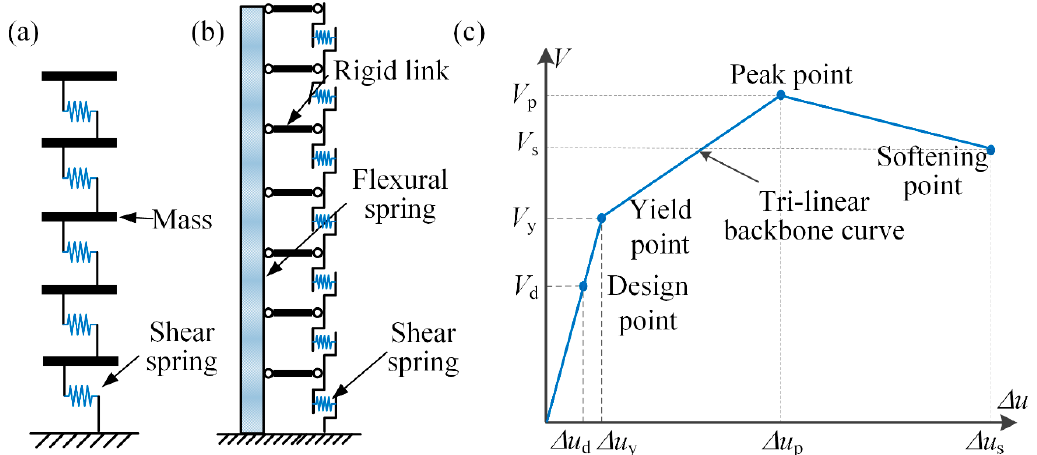
Figure 2. ( a ) Multiple-degree-of-freedom (MDOF) shear model; ( b ) MDOF flexural-shear model; and ( c ) trilinear backbone curve adopted in the MDOF model.